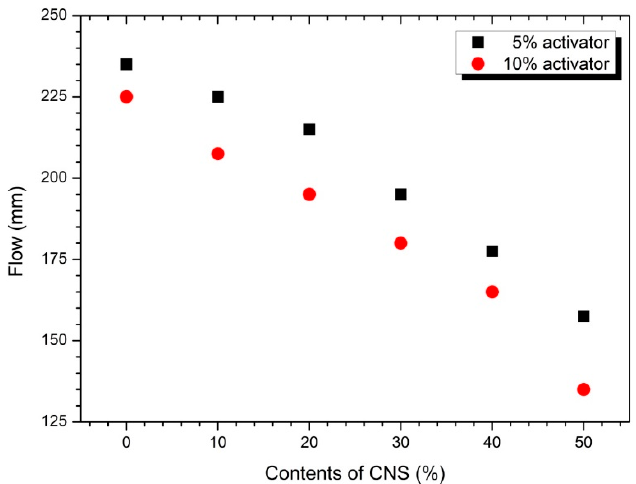
Figure 2. Flow values according to CNS replacement ratios in 5% and 10% activators.